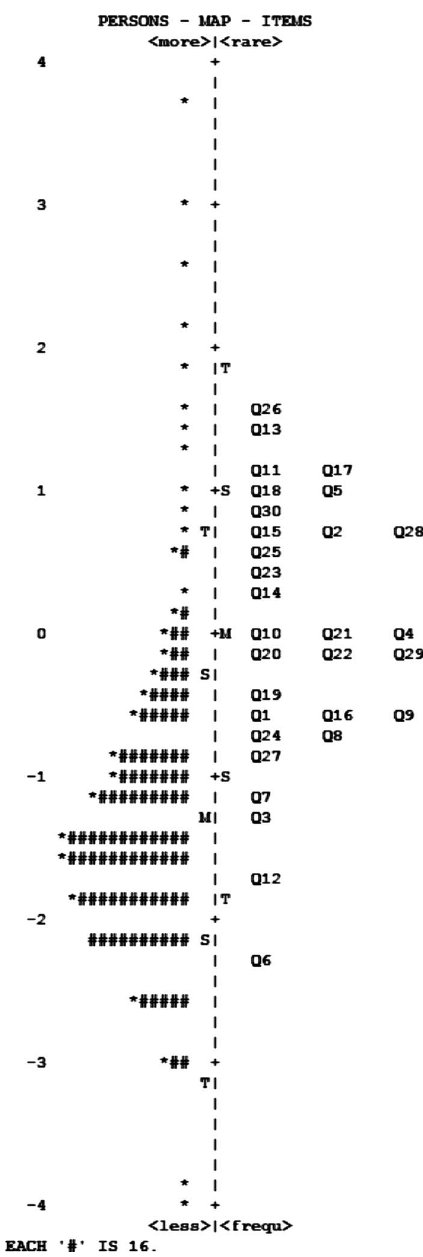
FIG. 3. Item-person map for gymnasium students. The left-hand side shows distribution of student abilities and the right-hand side shows the distribution of item difficulties. Items are labeled as Q1–Q30. M, S, and T are labels for the mean value, one standard deviation, and two standard deviations of each distribution. Each # represents 16 students and each * less than 16